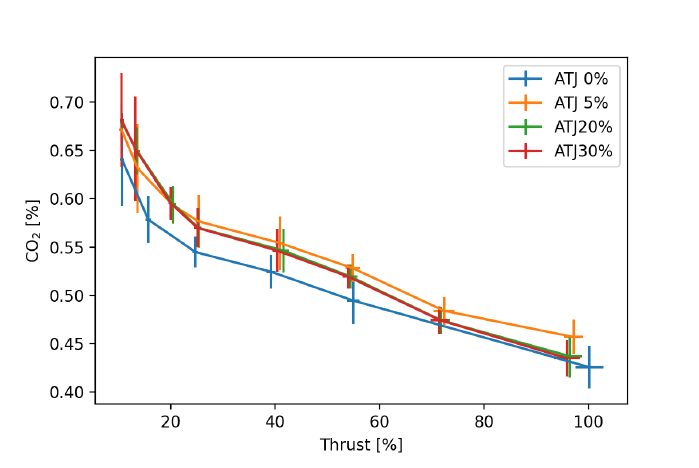
Figure 29. DGEN 380/ATJ: CO.